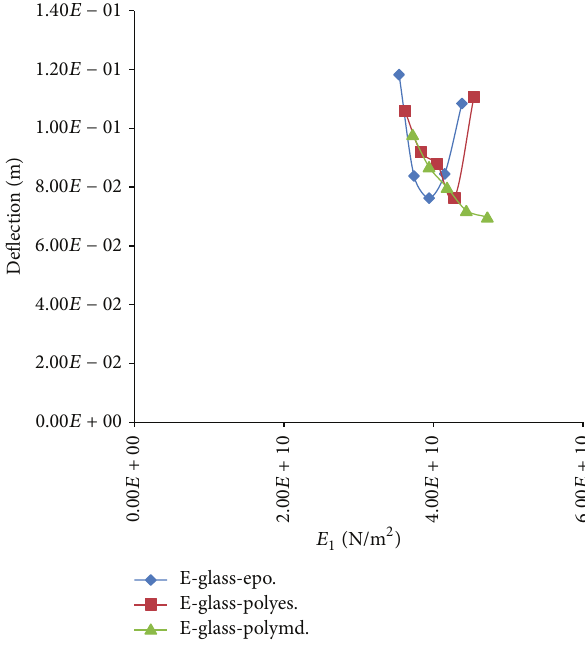
Figure 12: Effect of longitudinal modulus of elasticity on leaf spring deflection of various composite leaf springs based on matrix type.